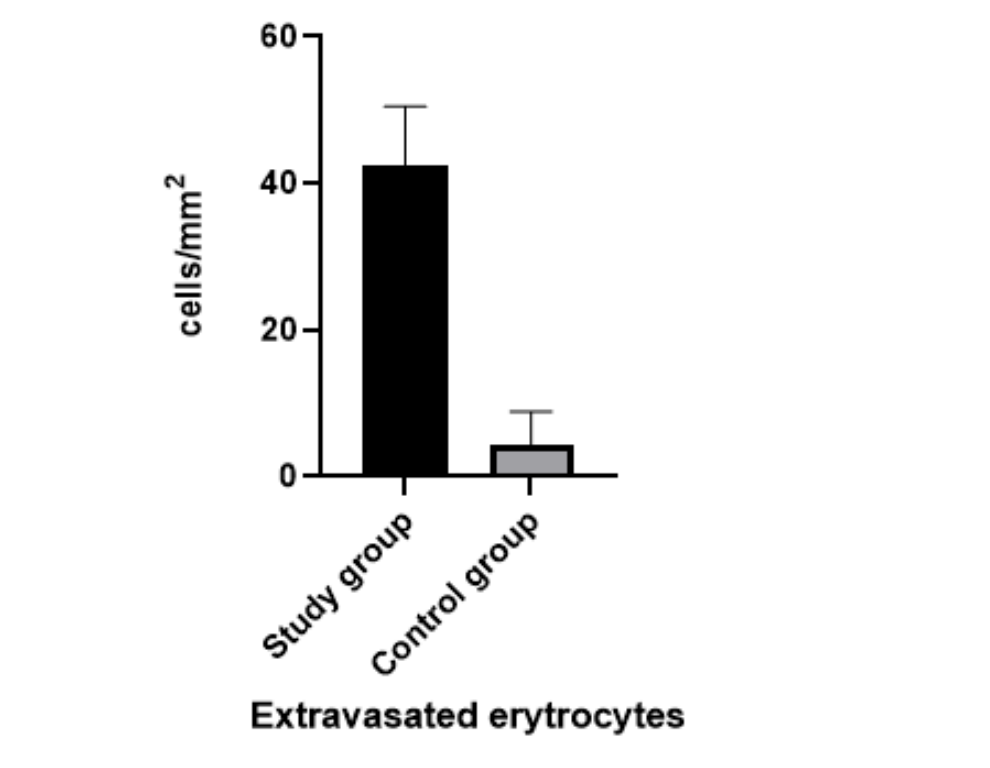
Figure 2. Graph showing the difference between the two study groups. Note that there was a statistically significant difference ( p < 0.001).